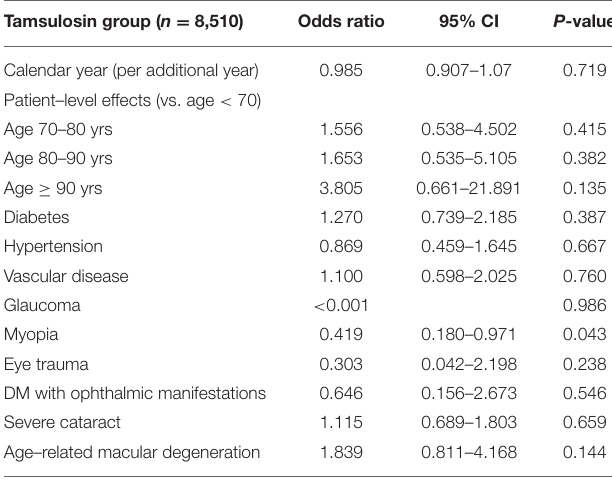
TABLE 3 | Effects of Calendar Year and Covariates on complication event of cataract surgery in the tamsulosin group.